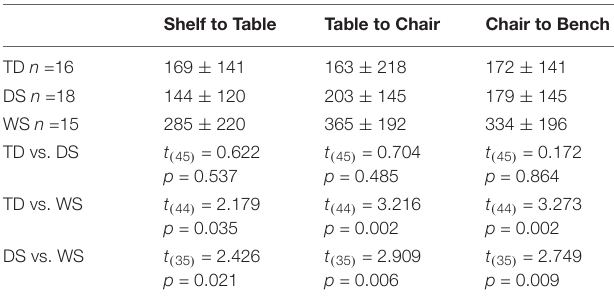
TABLE 9 | Cognitive mapping task. Distance from home, in